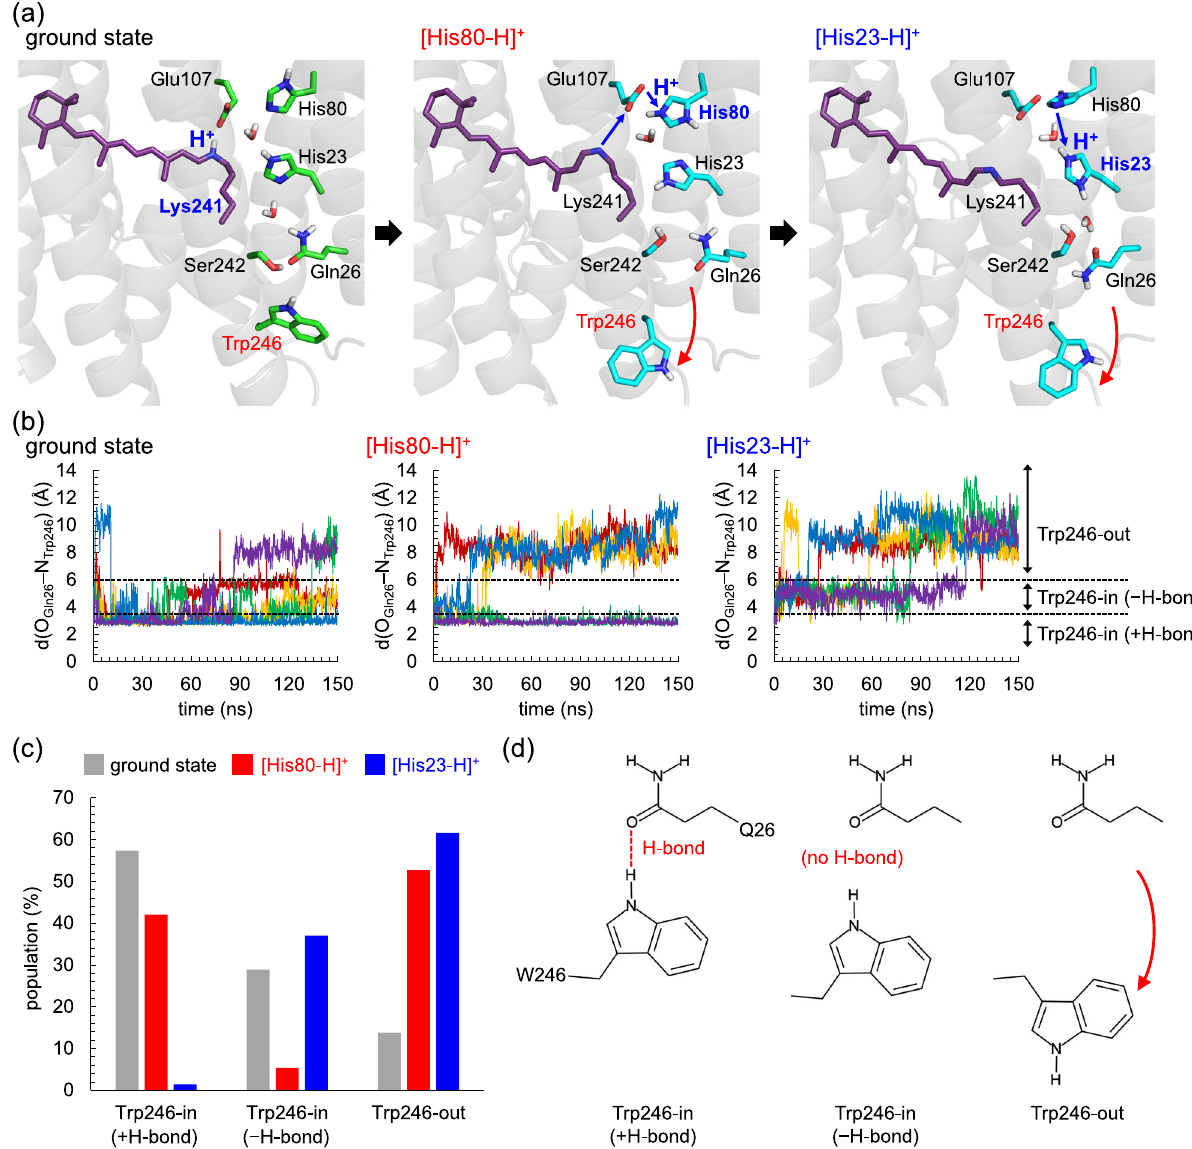
Fig. 5 Trp246 reorientation in response to His80/His23 protonation. a Transitions of the heliorhodopsin structures from the ground state (left panel) via M state with doubly protonated His80 ([His80-H] + , middle panel) to M state with doubly protonated His23 ([His23-H] + , right panel). Structures shown in the panels were obtained after 150-ns MD runs. b Distances between the side-chain O atom of Gln26 and the side-chain N atom of Trp246 (d(O Gln26 – N Trp246 ) in Å) during fi ve independent 150 ns MD runs for the ground, [His80-H] + , and [His23-H] + states. The Trp246 conformations are classi fi ed into the Trp246-in ( + H-bond), Trp246-in ( − H-bond), and Trp246-out conformations by d(O Gln26 – N Trp246 ). That is, the Trp246-in ( + H-bond) conformation for d(O Gln26 – N Trp246 ) < 3.5; the Trp246-in ( − H-bond) conformation for 3.5 ≤ d(O Gln26 – N Trp246 ) ≤ 6.0; the Trp246-out conformation for d(O Gln26 – N Trp246 ) > 6.0. c Populations of the Trp246-in ( + H-bond), Trp246-in ( − H-bond), and Trp246-out conformations observed during the fi ve independent 150 ns MD runs for the ground, [His80-H] + , and [His23-H] + states. d Trp246-in ( + H-bond), Trp246-in ( − H-bond), and Trp246-out